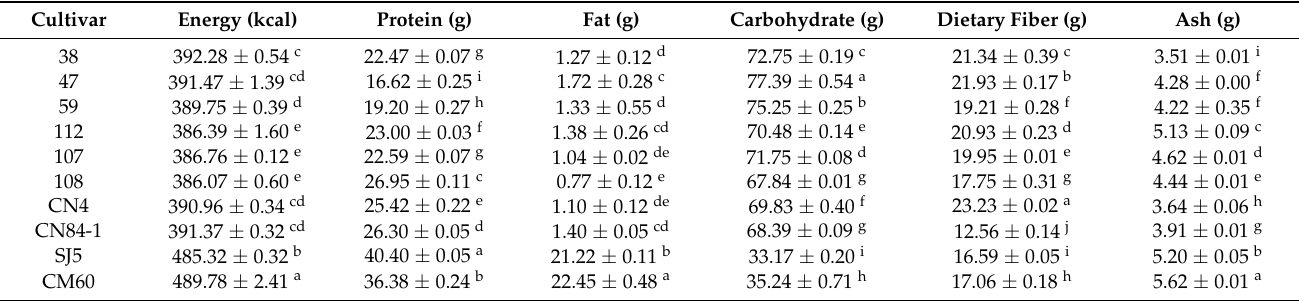
Table 2. Proximate compositions of ten bean cultivars (per 100 g dry weight).